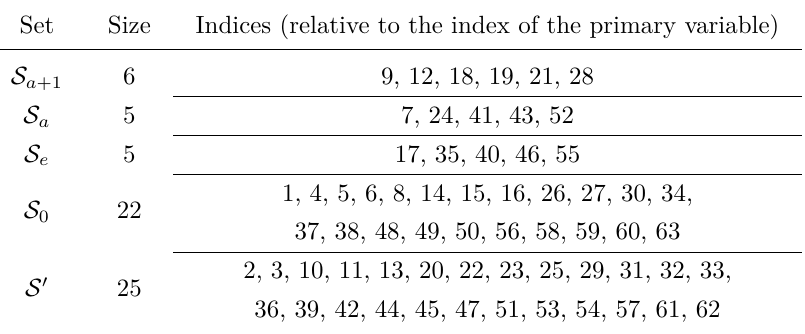
Table 3: The sets S a +1 , S a , S e , S 0 , S ′